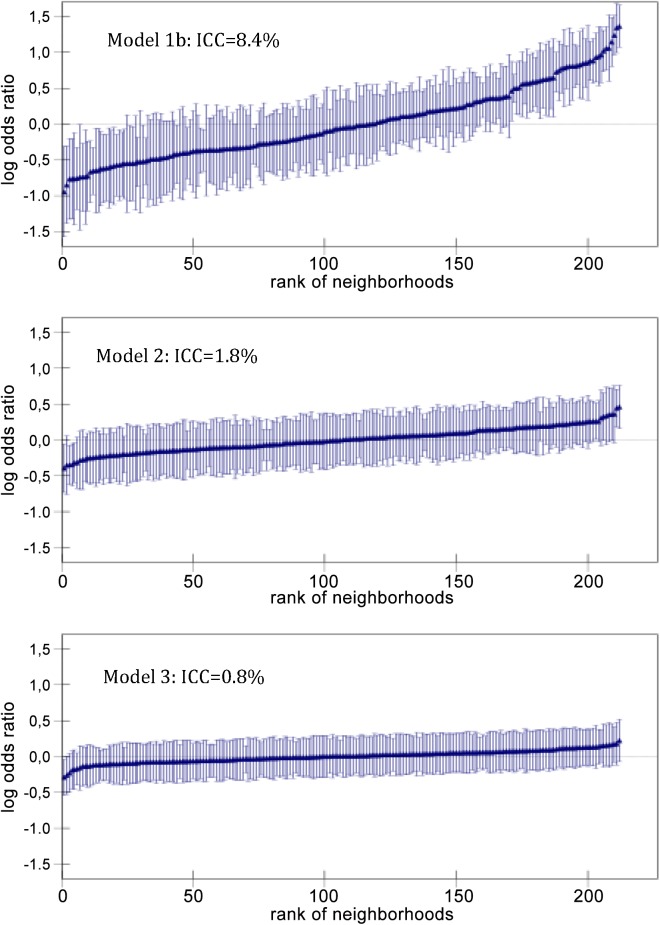
Residuals for Models 1b, 2 and 3.